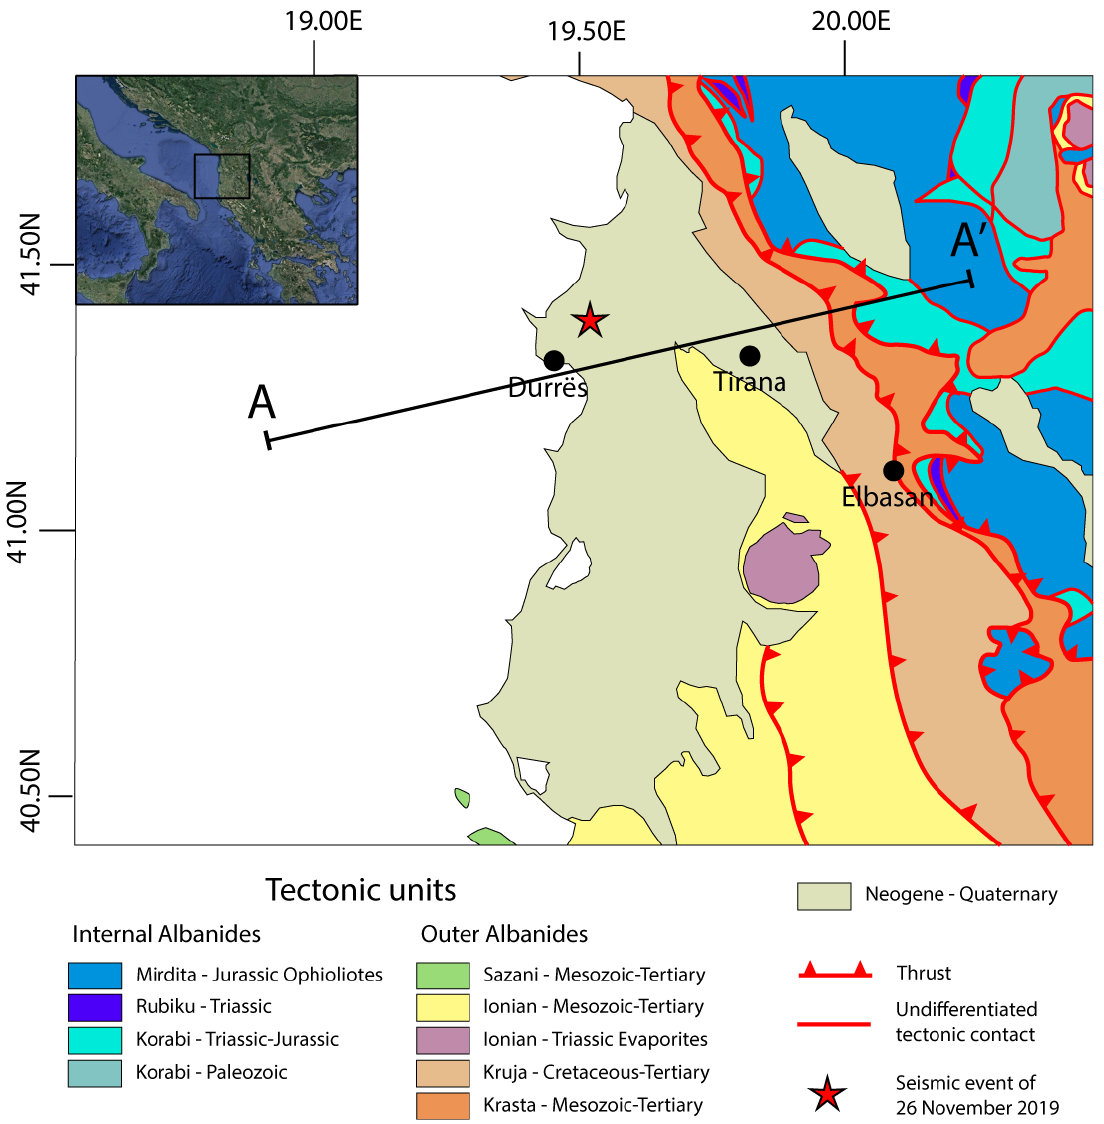
Figure 2. Tectonic sketch map of the study area (modified from Roure et al. [10], Muceku et al. [11,12]). The black line A-A’ shows the trace of the balanced and restored regional geological cross-section.